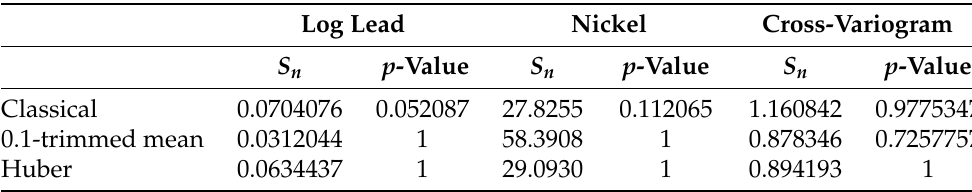
(cid:107) 2 (cid:98) γ ( h ) − 2 γ ( h ) (cid:107) and its p-value considering a scale contaminated Table 3. Values of S n = sup h normal with (cid:101) = 0.01 and g = 1.1 of Example